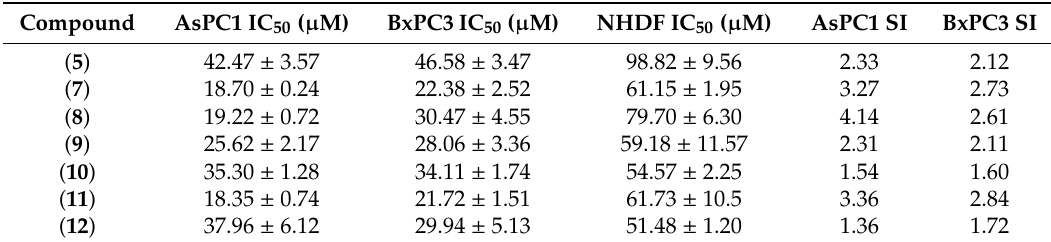
Figure 1. Cytotoxic e ff ects of ca ff eic acid (CA) and its derivatives (compounds 1 – 6 and 7 – 12 ), on two Figure 1 human pancreatic cancer cells lines AsPC1 ( a ), BxPC3 ( b ) and control NHDF ( c ) cells, determined by the MTT assay, after 72 h of incubation. Table 2. IC 50 values calculated from the MTT assay for biologically active ca ff eic acid derivatives. Selectivity index (SI) = IC 50 of NHDF / IC 50 of cancer cell